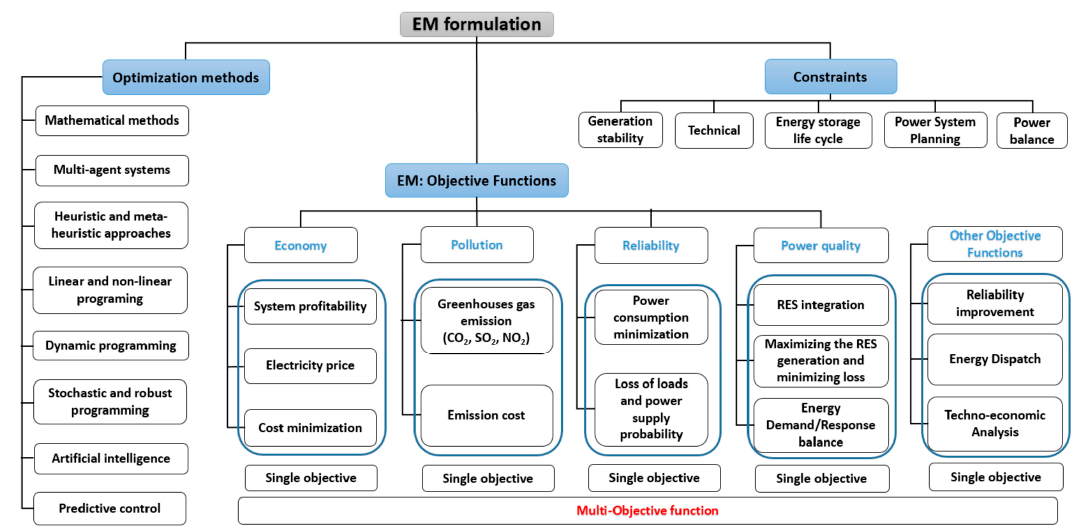
Figure 6. Objective functions constraints, and optimization methods for optimum operation of MG